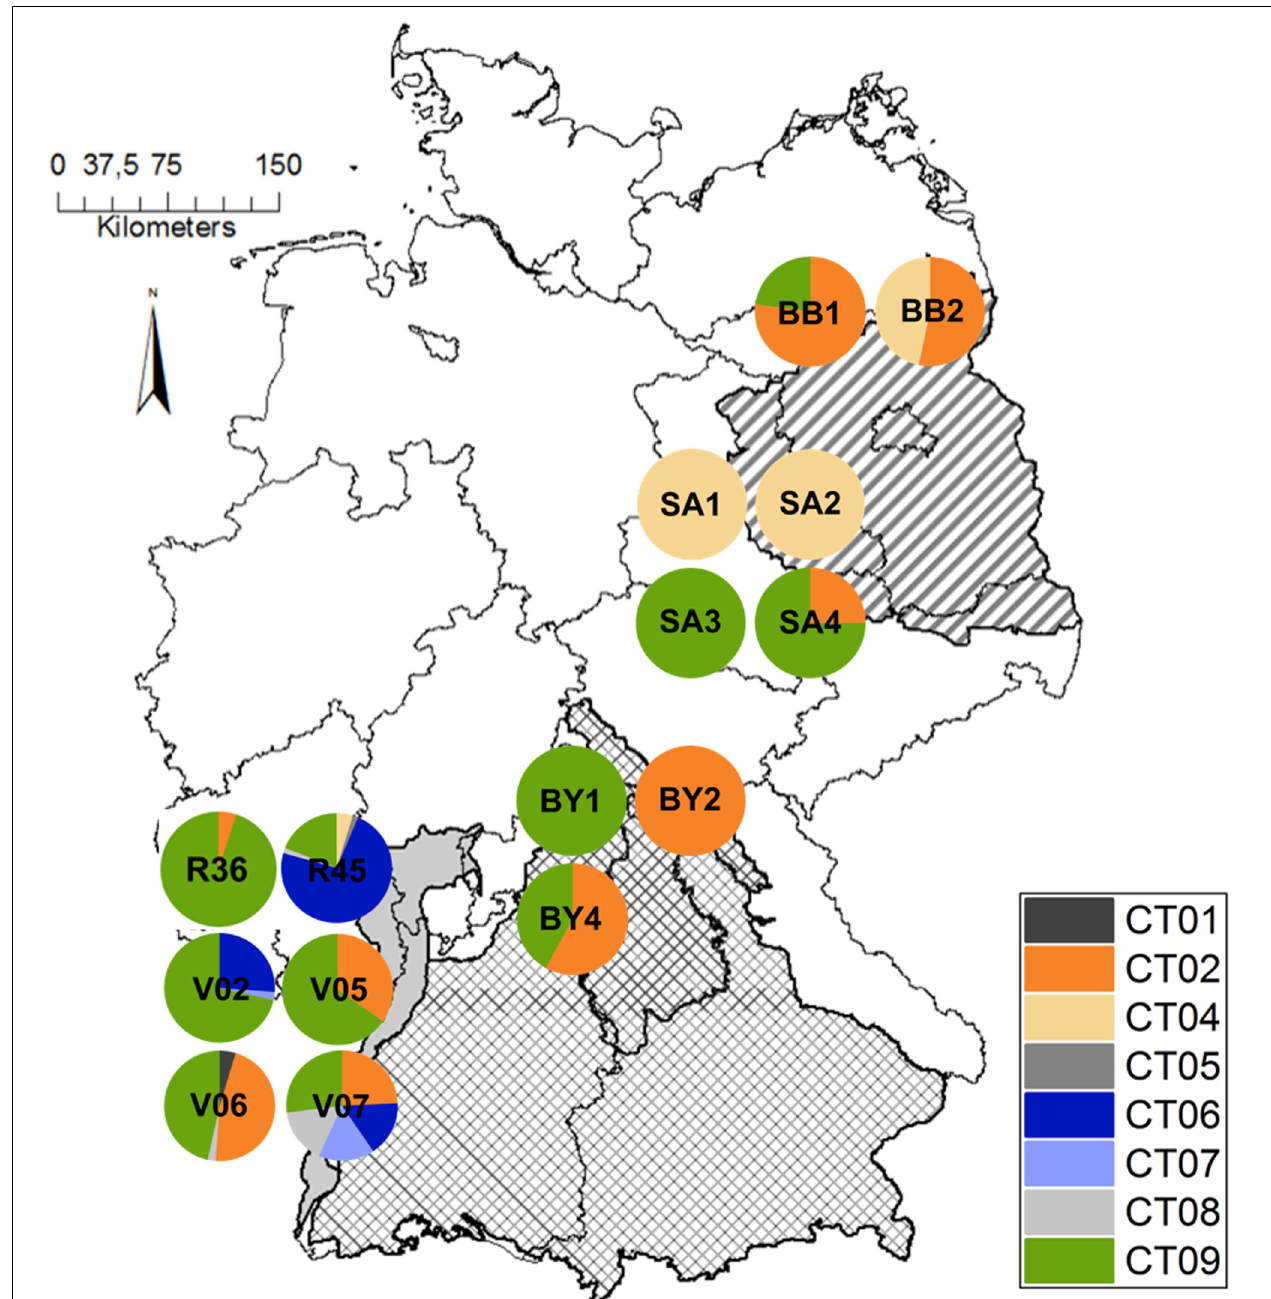
FIGURE 1 | Distribution of found chlorotypes (CT) in Q. robur individuals within sampled populations in Baden-Württemberg (R36, R45, V02, V05, V06, V07), Bavaria (BY1, BY2, BY4), Saxony-Anhalt (SA1, SA2, SA3, SA4) and Brandenburg (BB1, BB2). The three relevant German Q. robur provenances ‘Oberrheingraben’ (81707, gray uni), ‘Süddeutsches Hügel- und Bergland sowie Alpen’ (81709, checkered) and ‘Ostdeutsches Tiefland’ (81704, lined) are highlighted. The map of Germany is based on a map from Esri Germany